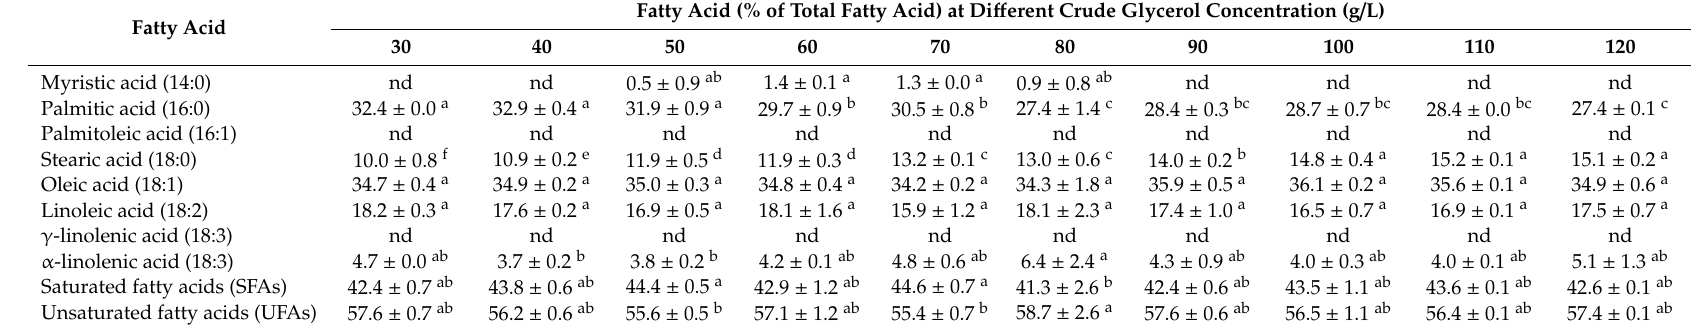
Table 1. Fatty acid profiles of lipid produced by Rhodosporidiobolus fluvialis DMKU-SP314 cultivated in the sugarcane top hydrolysate (STH) medium